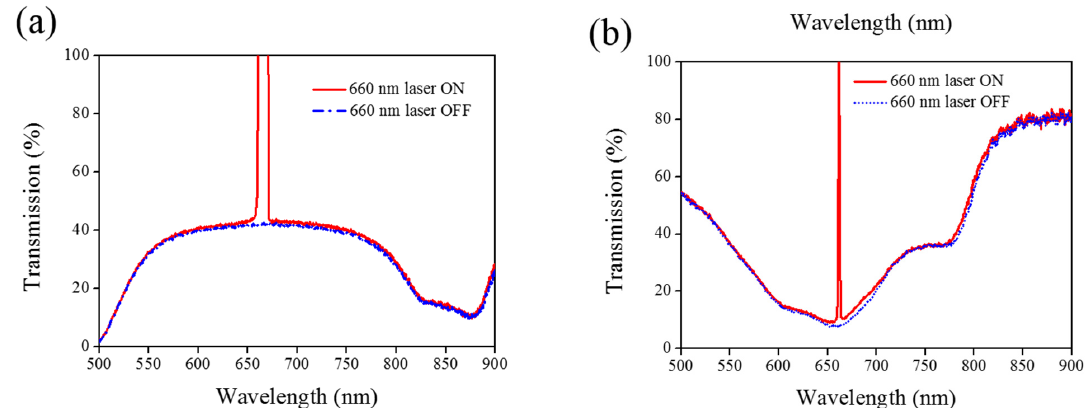
Figure 8. Transmission spectra of the sample without the addition of ( a ) AQ dye and ( b ) A4 under different conditions of laser exposure.